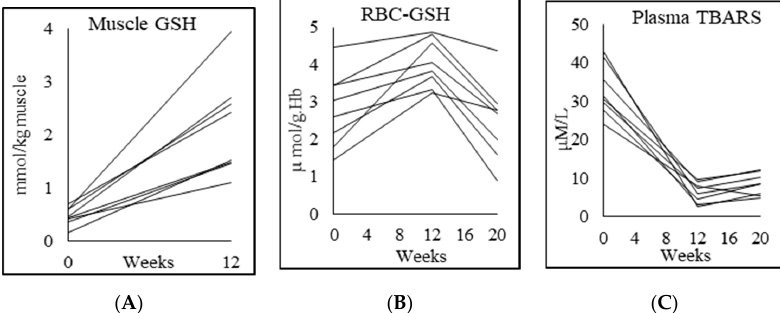
Figure 1. Individual participant data showing the effect of supplementing PWH with 12 weeks of Glycine and N-acetylcysteine and 8 weeks of withdrawal (as applicable). Shown here are ( A , B ) total GSH concentrations in muscle and RBC respectively and ( C ) plasma TBARS concentrations.